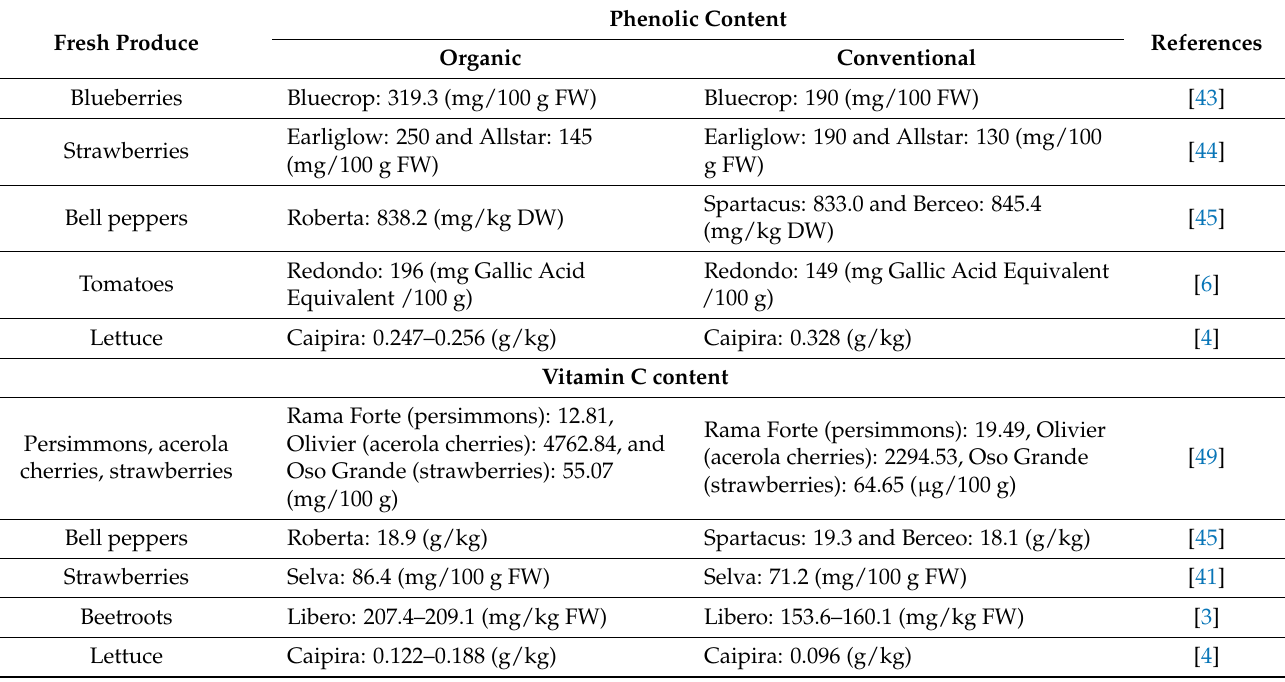
Table 8. Phenolic and vitamin C content of organic and conventional fresh